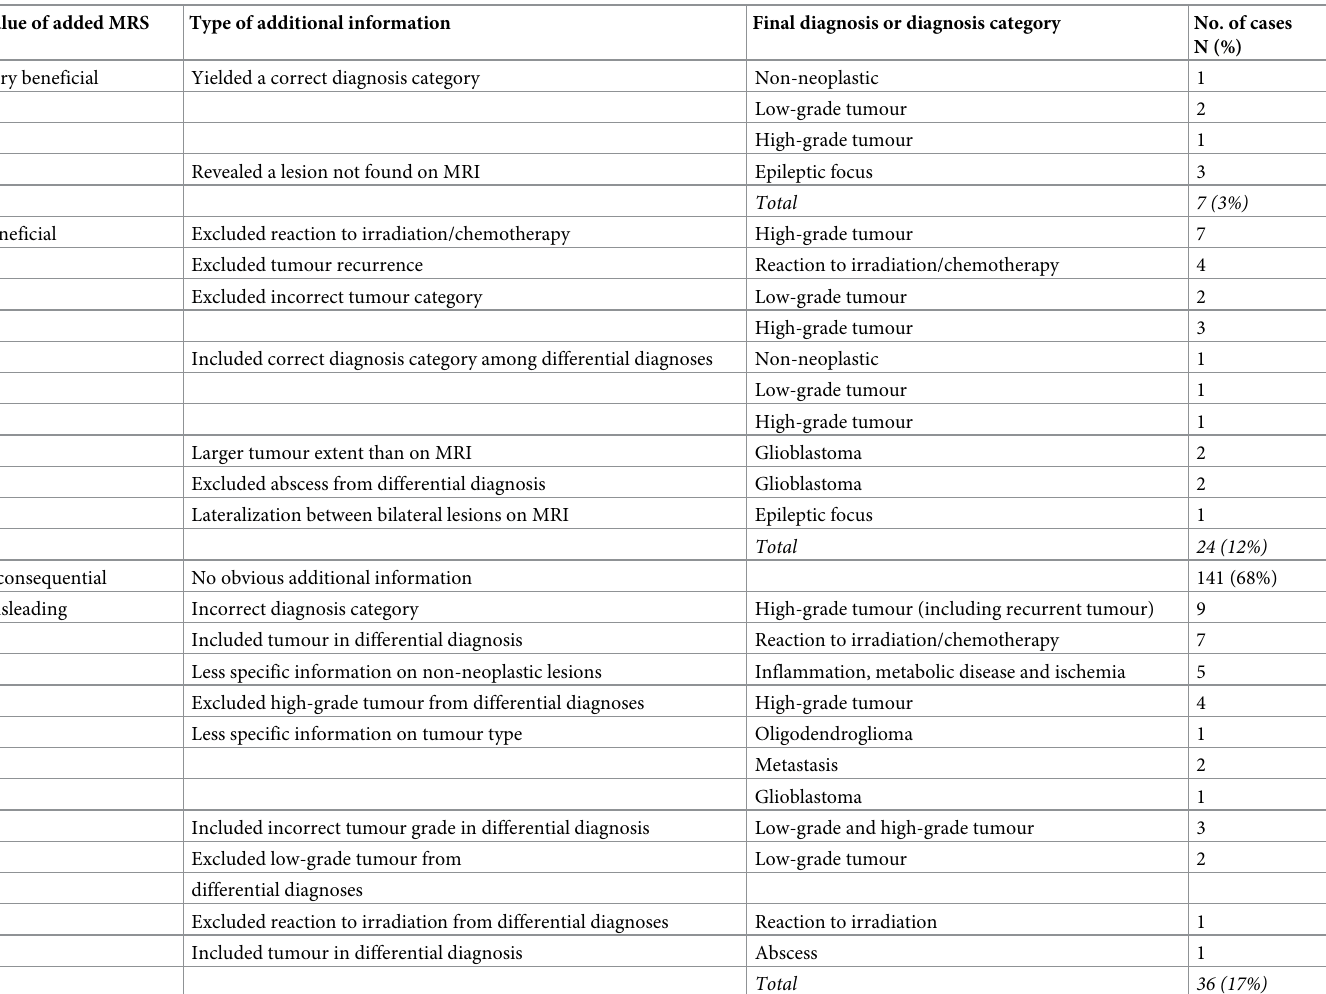
Table 9. Clinical benefit of the added MRS compared to MRI